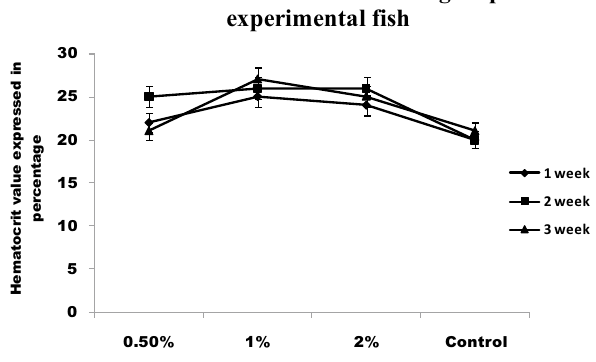
Figure 6. Hematocrit value of control fish group and experimental fish fed with CDP with basal diet.